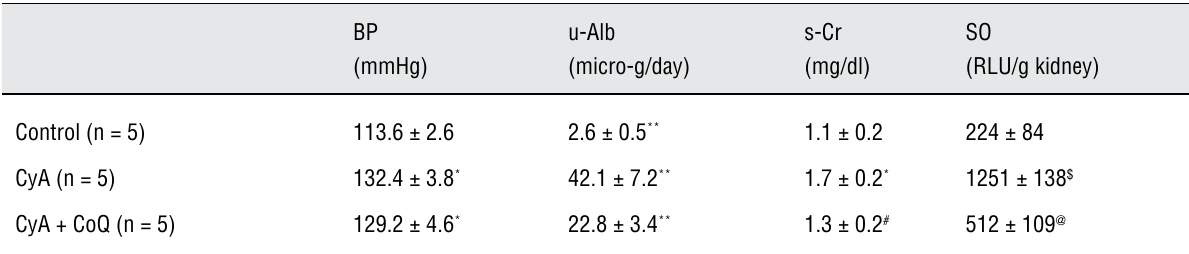
Table 1 - Changes of systolic blood pressure (BP), daily urinary albumin excretion (u-Alb), serum creatinine (s-Cr) level, super-oxide anion (SO) level in the